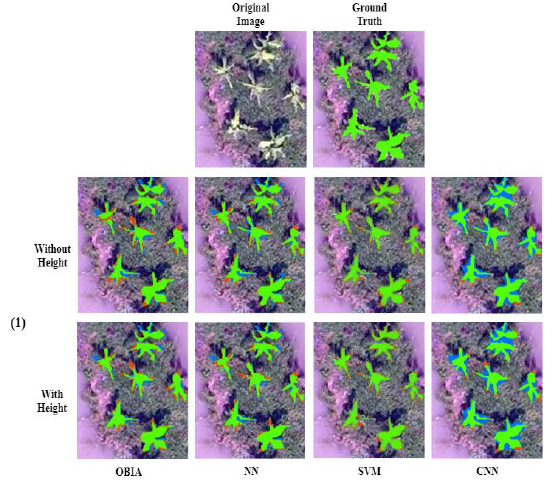
Figure 4. Visualization of prediction of four proposed model for Banana Tree Crown Delineation Image id